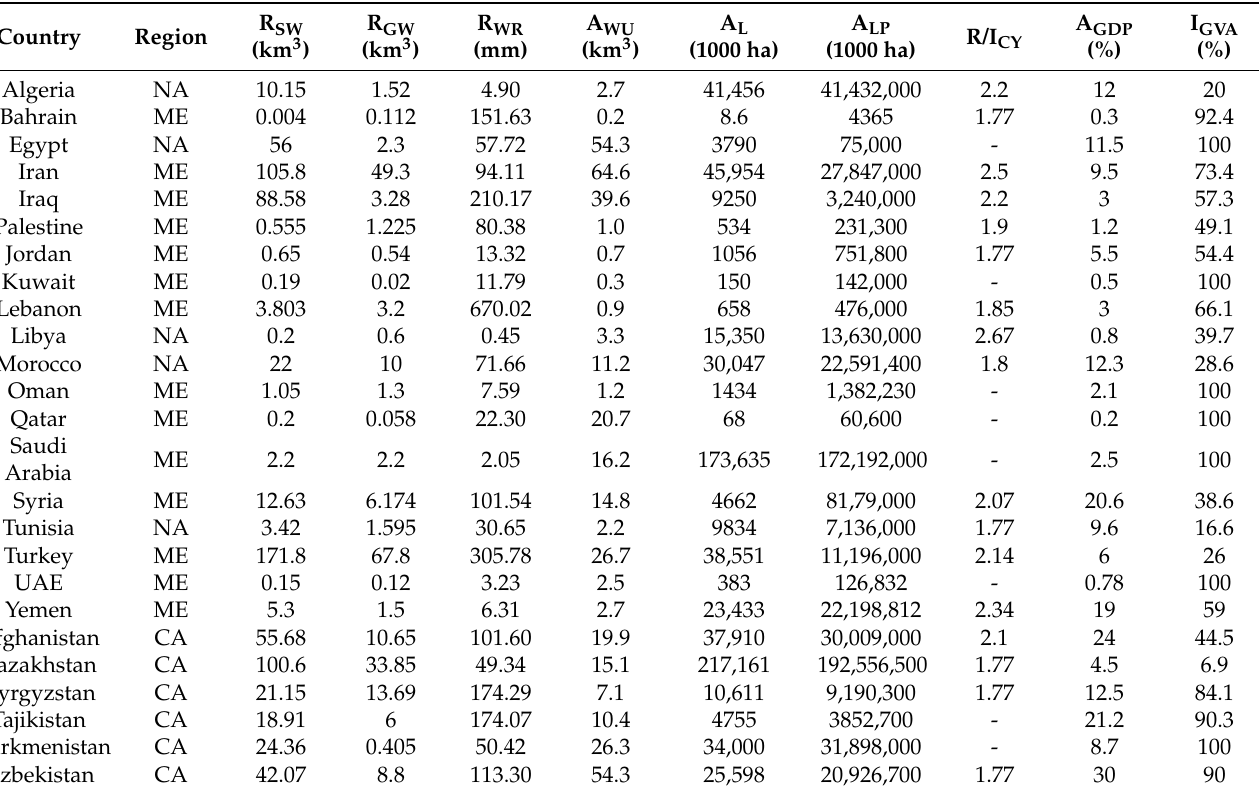
Table 1. The current water and agricultural situation of MENA and Central Asian Countries. R SW : renewable surface water resources, R GW : renewable groundwater resources, R WR : total renewable water resources volume, A WU : annual total renewable water volume, A L : agricultural land, A LP : plausible agricultural land, R/I CY : rainfed per irrigated crop yield, A GDP : agricultural gross domestic product (GDP), I GVA : irrigated gross value added in agricultural GDP [12,13]. In the region column, ME: Middle East, NA: Northern Africa, CA: Central